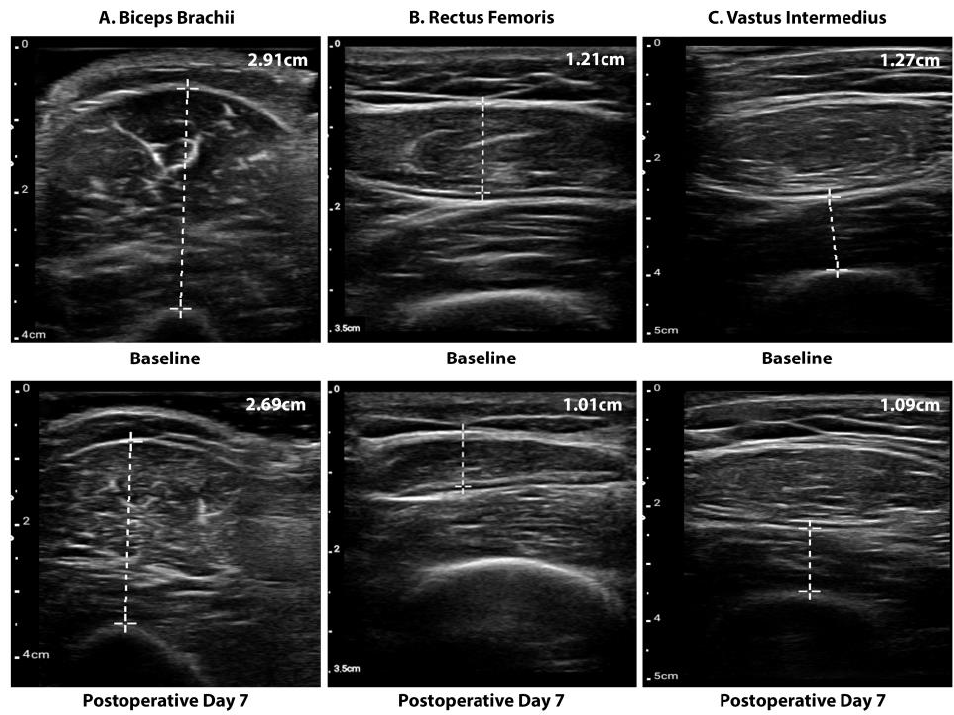
Figure 1. Representative images of ultrasound muscle measurements of the cross-section (ante- rior/posterior diameter) of ( A ) the m. bicieps brachii, ( B ) the m. rectus femoris and ( C ) the m. vastus intermedius at baseline (upper images) and after 7 days postoperatively (lower images).